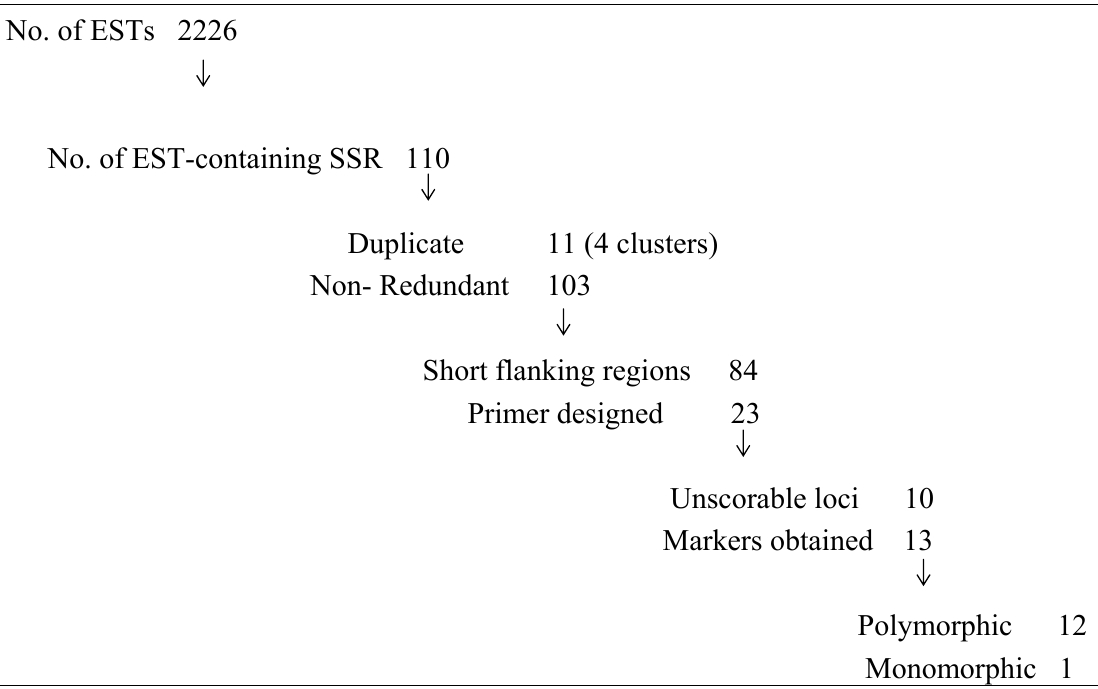
Table 2. The fates of EST sequences of European perch ( Perca fluviatilis ) used for Type I marker development for yellow perch ( P. flavescens